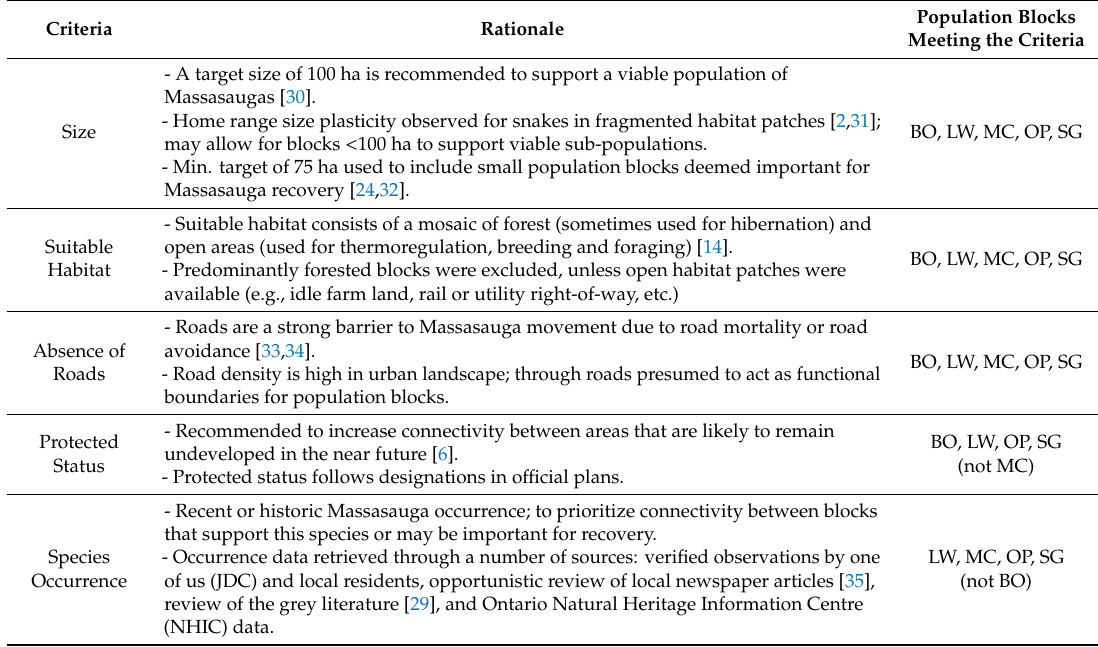
Table 1. Criteria for selection of population blocks, with rationale, for a landscape connectivity analysis targeting the Massasauga rattlesnake in an urban park system in southwestern Ontario, Canada. Criteria